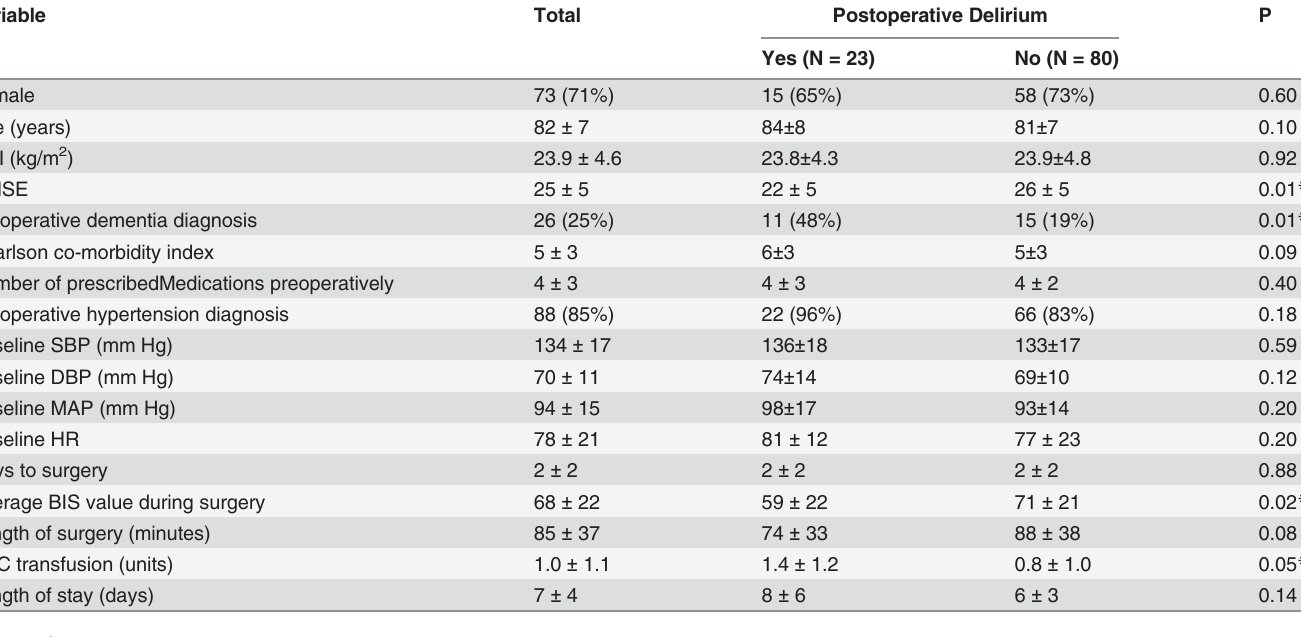
Table 1. PATIENT CHARACTERISTICS, presented as N (%) or MEAN ±